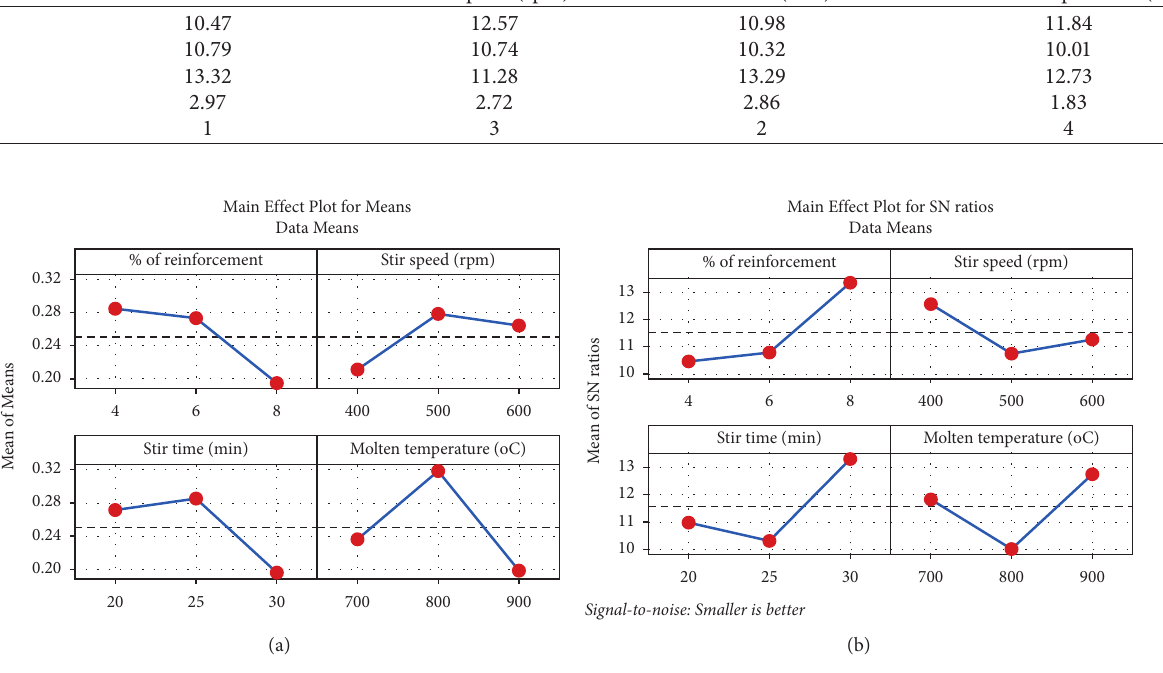
Figure 3: Main effects plots for wear test. (a) Means. (b) S/N